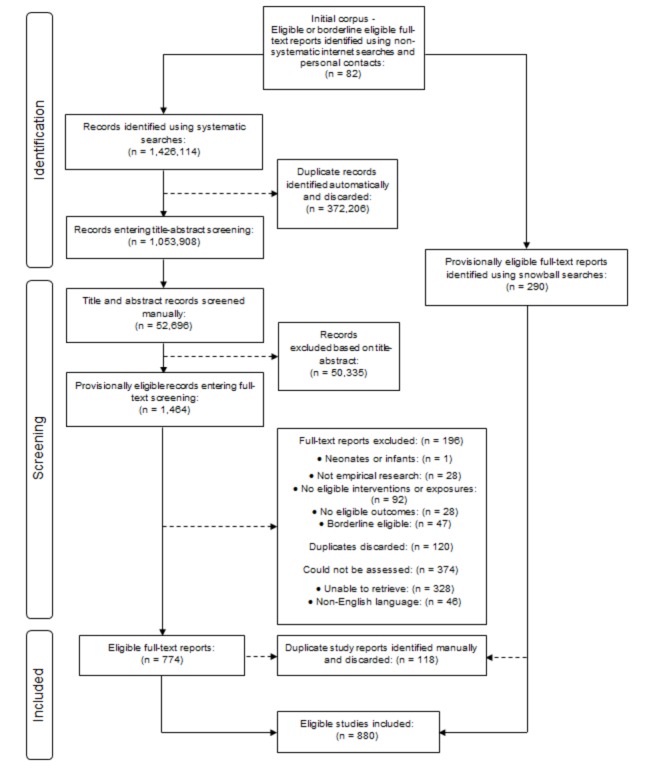
PRISMA flow diagram.